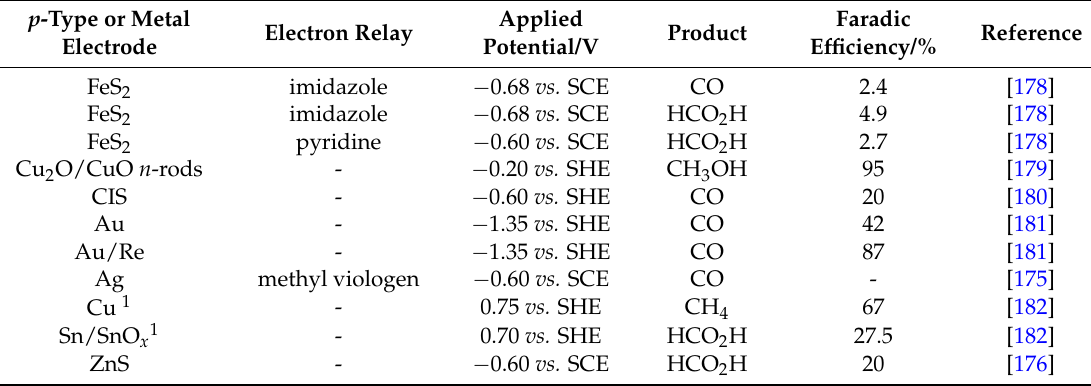
Table 6. Semiconducting p -type and metallic electrodes for the photo- and electro-chemical reduction of CO 2 . The electron relays, the conditions of photoelectrolysis and faradic efficiencies are also reported. p -Type or